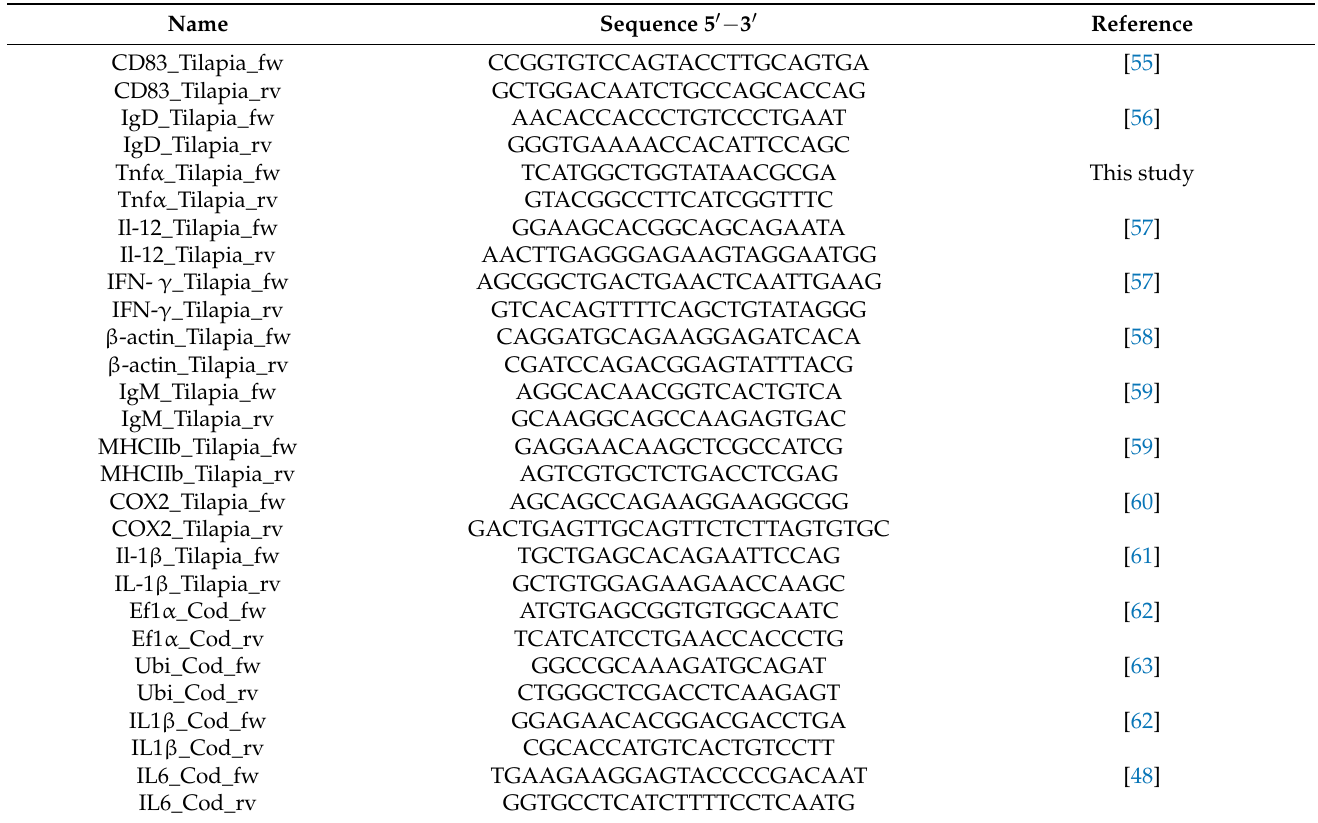
Table A1. List of primer used for qPCR and bacterial